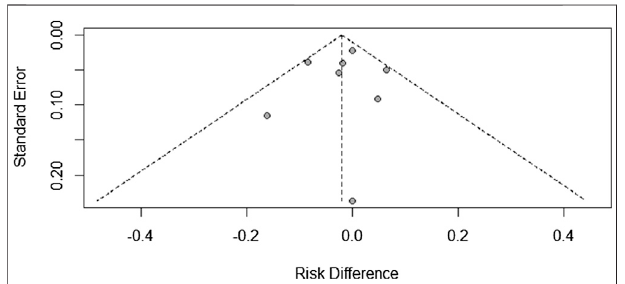
FIGURE 5 | Funnel chart of included